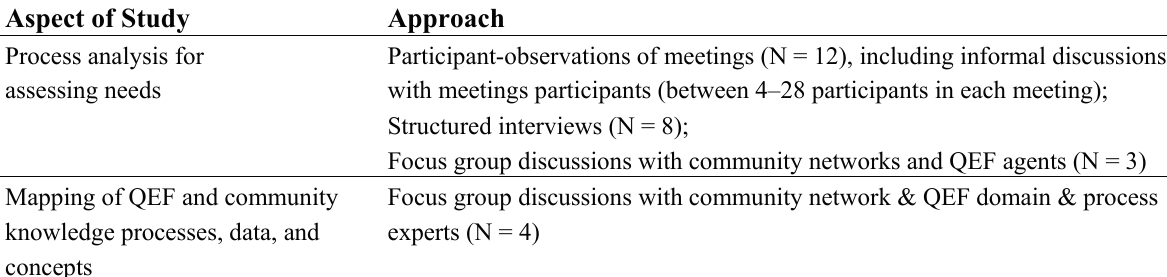
Table 2. Study participants and